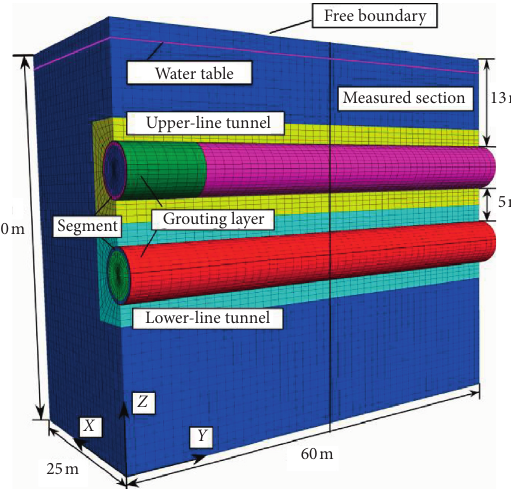
Figure 4: Half of the Flac3D numerical simulation